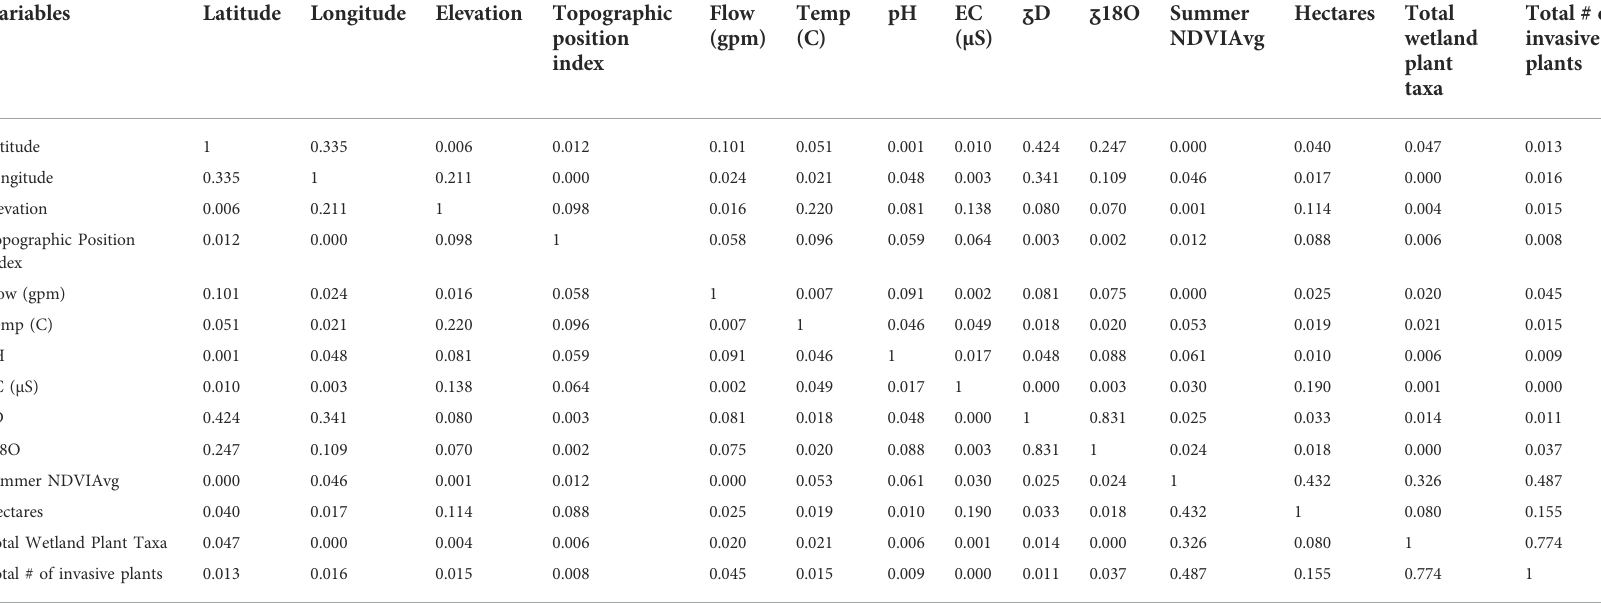
TABLE 2 Linear correlation among ecohydrological parameters for 48 California Desert springs. Values shown are Pearson coef fi cients of determination (r 2 ). Variables